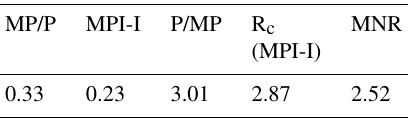
Table 2. Maturity indices (based on aromatic hydrocarbons) of the Dresser kerogen. MP/P: methylphenathrene / phenanthrene ratio; MPI-I: methylphenanthrene index (1.5 · (2-MP + 3- MP)/(P + 1-MP + 9-MP); Radke and Welte, 1983); P/MP: phenanthrene / methylphenathrene ratio; R c (MPI-I): computed vitrinite reflectance (0.7 · MPI-1 + 0.22, according to P/MP > 1; Boreham et al., 1988); MNR: methylnaphthalene ratio (2-MN/1- MN; Radke et al.,